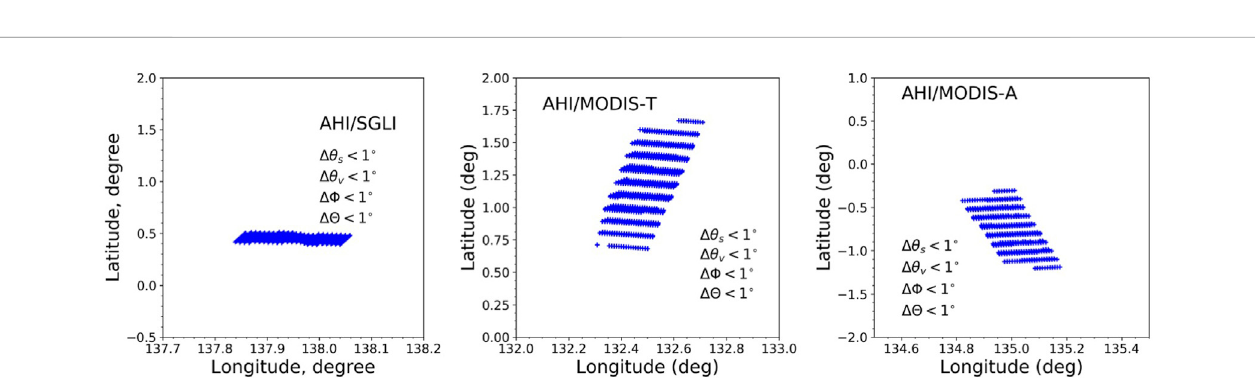
FIGURE 4 LocationofclearskyAHI/SGLI(01:10GMT,225pixelsintotal,left),AHI/MODIS-A(04:30GMT,381pixelsintotal,middle),andAHI/MODIS-T (01:30GMT, 619 pixels in total, right) coincidences for 25 January 2020, i.e., differences in solar zenith ( Δ θ s ), view zenith ( Δ θ v ), relative azimuth ( Δ ϕ ), and scattering angle ( Δ Θ ) are less than 1 °